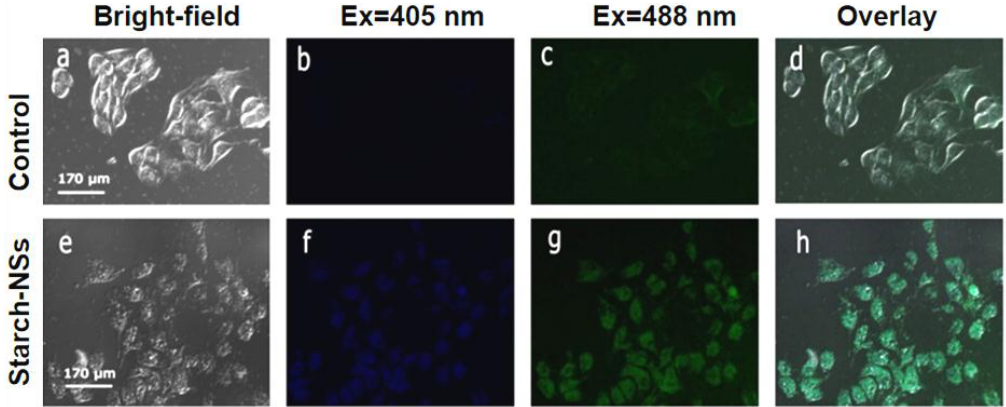
Figure 8. Laser scanning confocal microscopy images of mouse melanoma cells under bright-field, with excitation at 405 and 488 nm. The cells without polysaccharide-based NSs used as a control. Scale bar = 170 µm. ( a ) Bright-field image, fluorescence image by excitation at ( b ) 405 and ( c ) 488 nm, as well as ( d ) overlay of images of ( a ) and ( c ) for mouse melanoma cells without polysaccharide-based NSs. ( e ) Bright-field image, fluorescence image by excitation at ( f ) 405 and ( g ) 488 nm, as well as ( h ) overlay of images of ( e ) and ( g ) for mouse melanoma cells incubated with polysaccharide-based NSs.